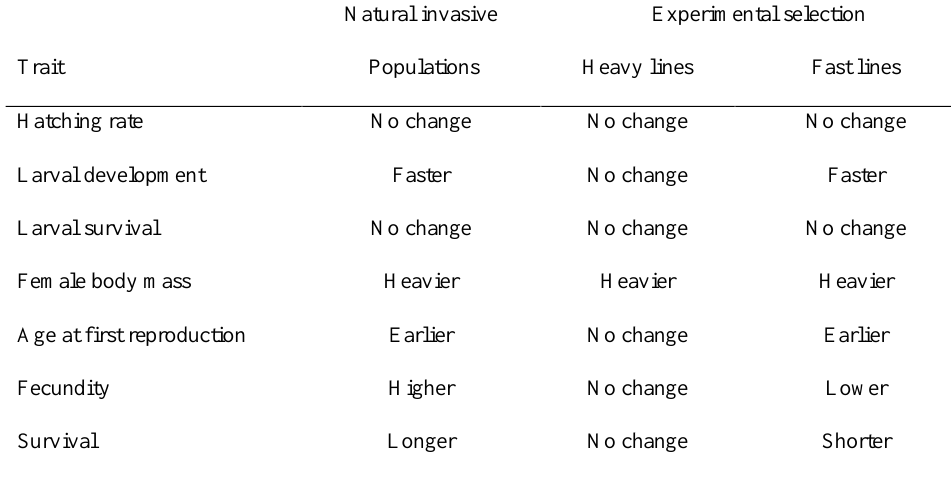
Table 1: Phenotypic changes observed in invasive populations of H. axyridis that contribute to the invasion syndrome and the corresponding changes displayed by the experimental lines of the selection experiments achieved in the present study on female body mass (heavy lines) and age at first reproduction (fast lines) using an ad libitum nutritional environment for the phenotyping step. See Facon et al. 2011, Tayeh et al. 2012 and Tayeh et al. 2015 for additional details about phenotypic characteristics of invasive H. axyridis